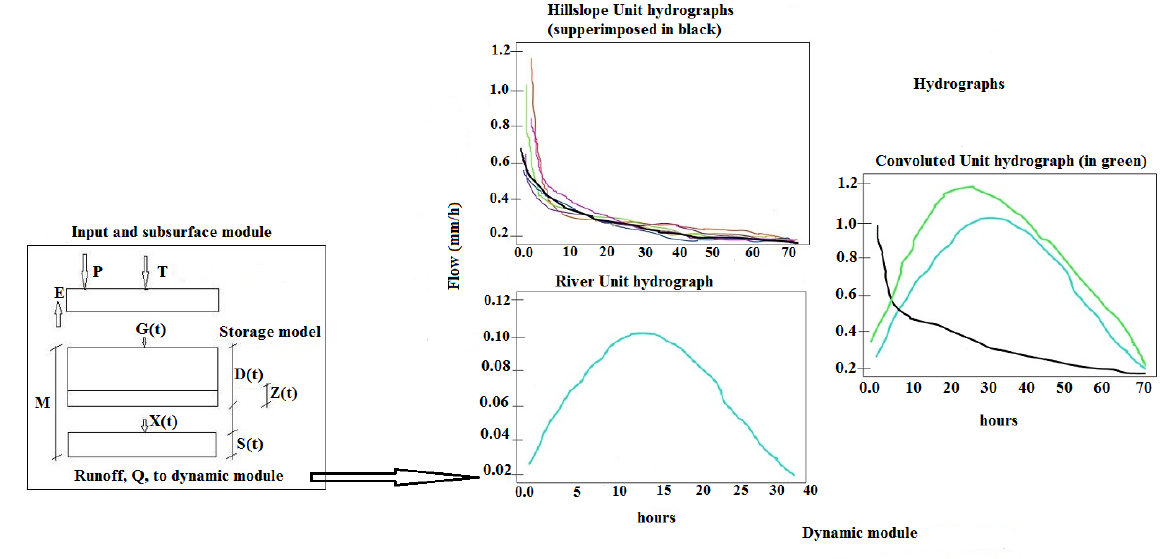
Figure 2. Structure of the distance distribution dynamics model adapted from Skaugen and Onof (2014). Left panel: the storage model. Right panel: hydrographs of hillslope and river. P is precipitation, T is temperature, E is actual evapotranspiration, G(t) is input from snowmelt and rain, Z(t) is soil moisture in the unsaturated zone, X(t) is excess water, M is total volume of subsurface water reservoir, S(t) is a saturated zone volume, and D(t) is unsaturated zone volume.